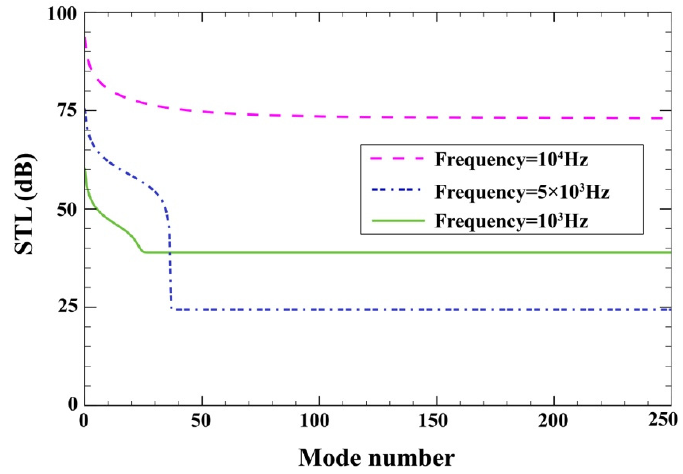
Figure 2. Mode convergence diagram. Table 1. Material properties of the honeycomb sandwich cylindrical shell with FGP